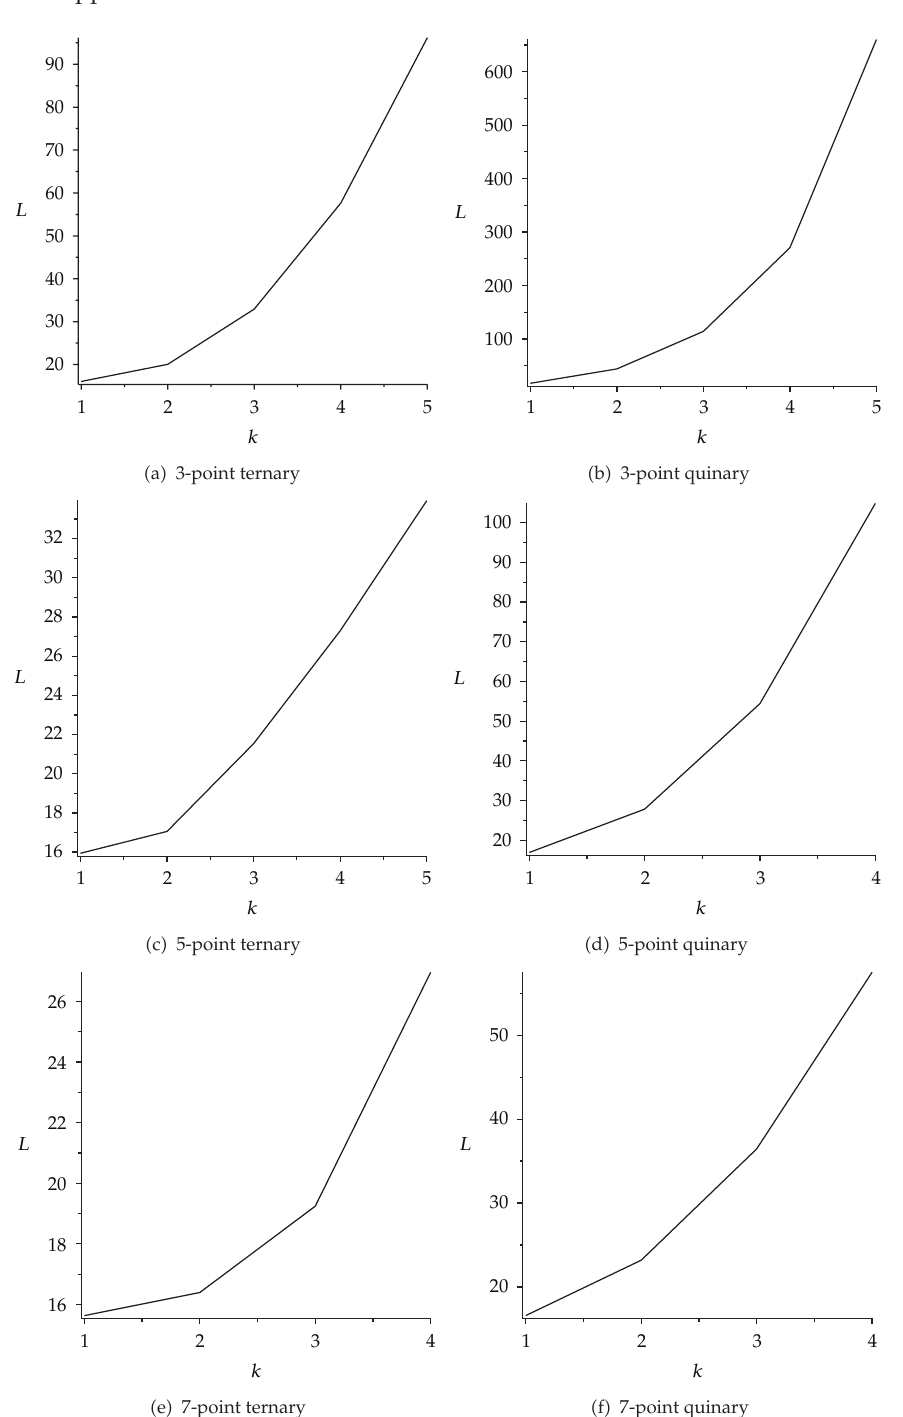
Figure 3: Comparison of total absolute curvature of 3-point ternary and 3-point quinary, 5-point ternary and 5-point quinary, and 7-point ternary and 7-point quinary interpolating schemes. Here L represents total absolute curvature and k represents number of